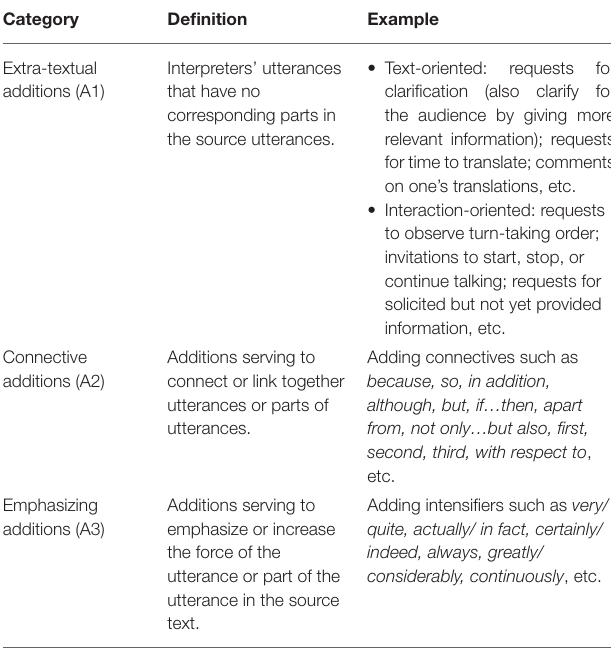
TABLE 1 | Typology of additions for the present